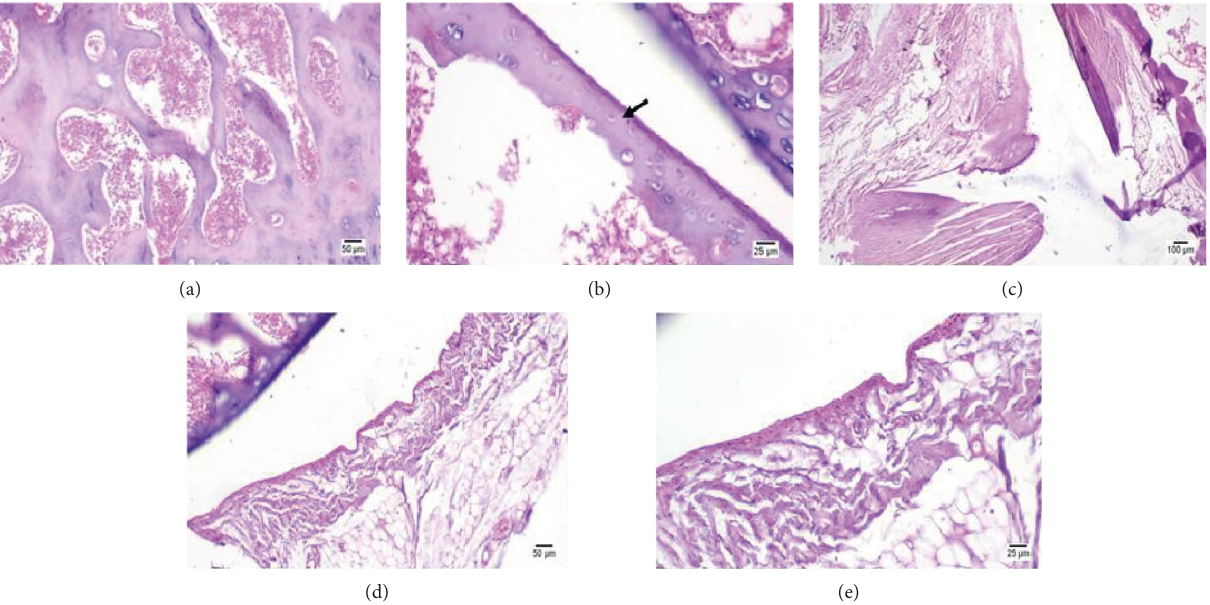
Figure 8: (a) Group (200 ppm) showing mild thinning in the articular cartilage (arrow), normal synovial membrane, and joint capsule (star); (b) mild thinning in the articular cartilage (arrow); (c) normal synovial member joint capsule; (d) synovial membrane and joint capsule; and (e) higher in higher magnification, showing normal synovial membrane and joint